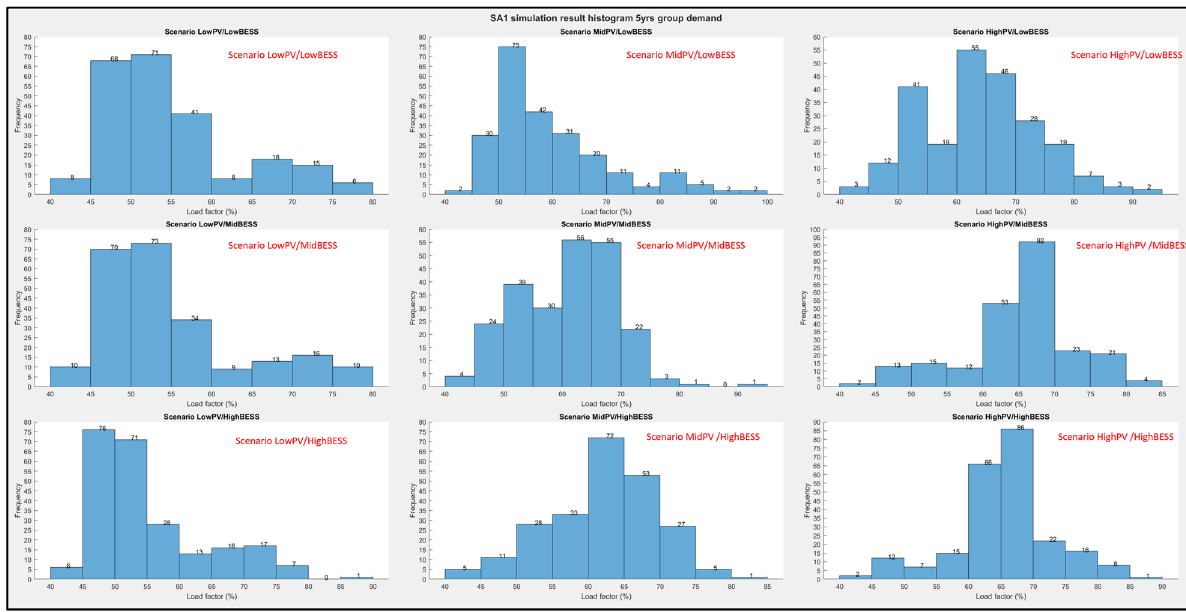
Figure 12. Histogram plots of SA1 simulation results for load factor